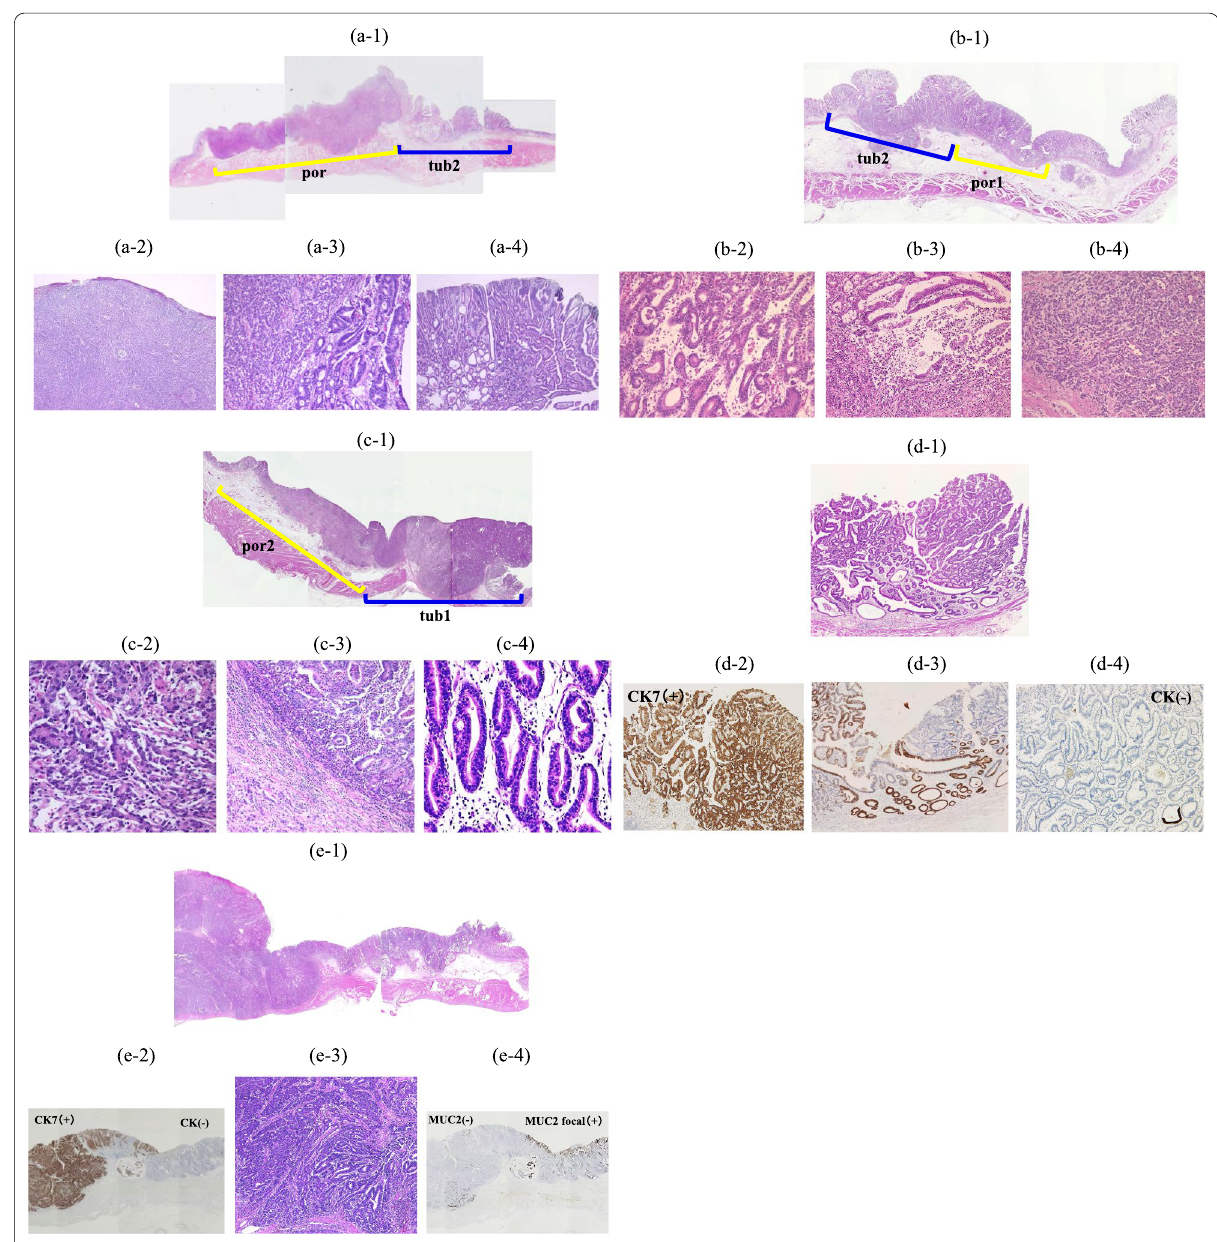
Fig. 3 Histopathological findings of the resected specimen. a-1–a-4 Case 1: a lesion with a poorly differentiated adenocarcinoma (por) collided with a lesion with a moderately differentiated tubular adenocarcinoma (tub2). a-1 Loupe image (hematoxylin–eosin [HE]), a-2 por (HE, 40), × a-3 border of the two lesions (HE, 100), a-4 tub2 (HE, 40) b-1–b-4 Case 2: a lesion with tub2 collided with a lesion with poorly differentiated × × adenocarcinoma (solid type, por1). b-1 Loupe image (HE), b-2 tub2 (HE, 100), b-3 border of the two lesions (HE, 40), b-4 por1 (HE, 100). × × × c-1–c-4 Case 3: a lesion with poorly differentiated adenocarcinoma (non‑solid type, por2) collided with a lesion with well‑differentiated tubular adenocarcinoma (tub1). c-1 Loupe image (HE, c-2 por2 (HE, 100), c-3 border of the two lesions (HE, 40), (c‑4) tub1 (HE, 100). d-1–d-4 Case 4: × × × two tumors were similar tub2; however, they had a different positivity for CK 7. d-1 Loupe image (HE), d-2 CK positive ( 40), d-3 border of the two × lesions ( 40), d-4 CK 7‑negative ( 40). e-1–e-4 Case 5: Two tumors were similar tub2; however, one tumor was CK 7‑positive and MUC2‑negative; × × and the other was CK 7‑negative and MUC2 focally positive. e-1 Loupe image (HE), e-2 CK 7 staining ( 20), e-3 border of the two lesions (HE, 40), × × e-4 MUC2 staining ( ×